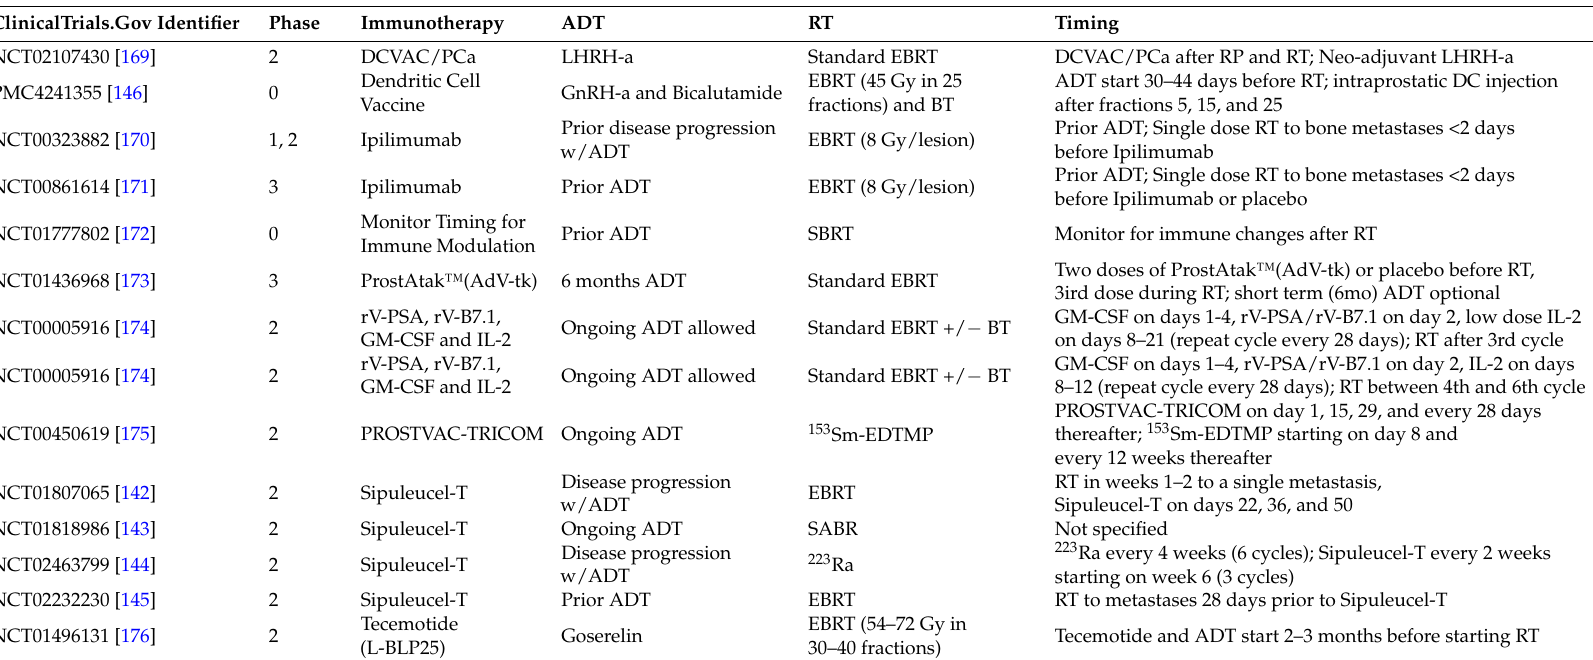
Table 1. Current clinical trials involving immunotherapy in combination with ADT and RT in PCa (completed and in-progress). ClinicalTrials.Gov